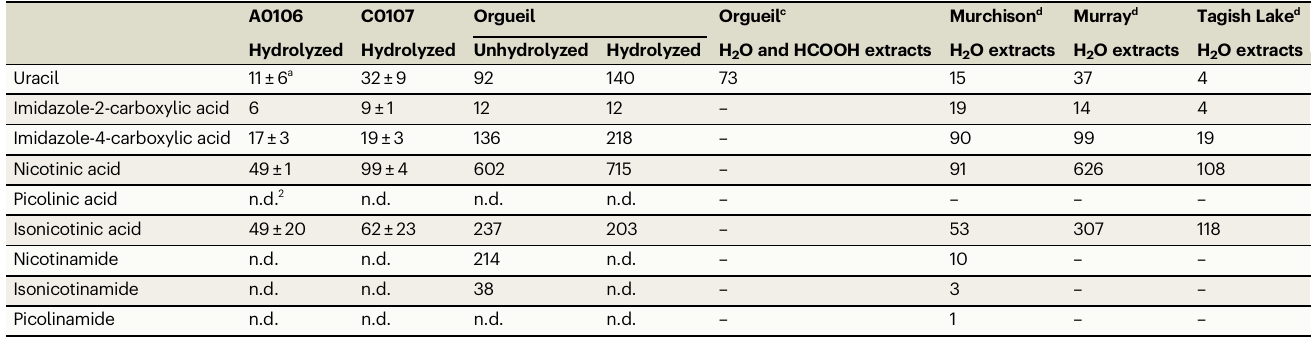
Table 1 | Qualitative and quantitative summary (in ppb) of uracil and other N-heterocyclic molecules identi fi ed in the Ryugu samples (A0106, C0107) and Orgueil